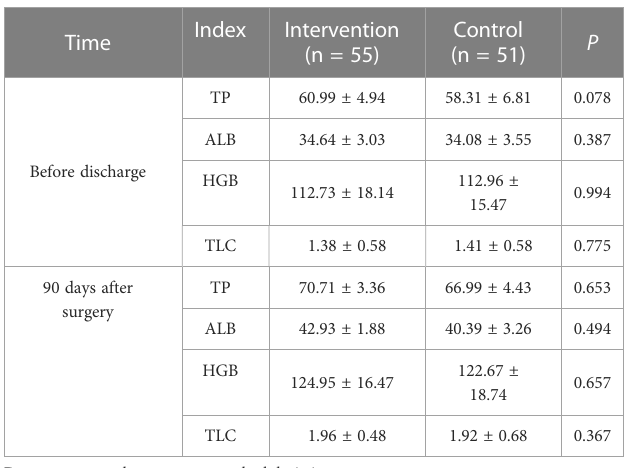
TABLE 4 Evaluation of patient blood